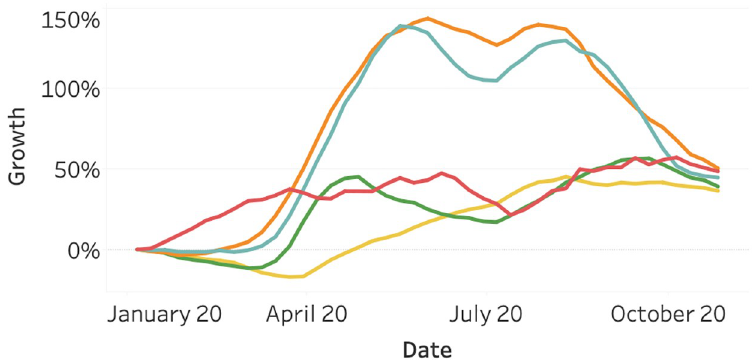
Fig 5. Online searches for bicycle through Google as of January 2020, split per continent. North America (orange), South America (yellow), Asia (red), Europe (light blue), and Oceania (green).